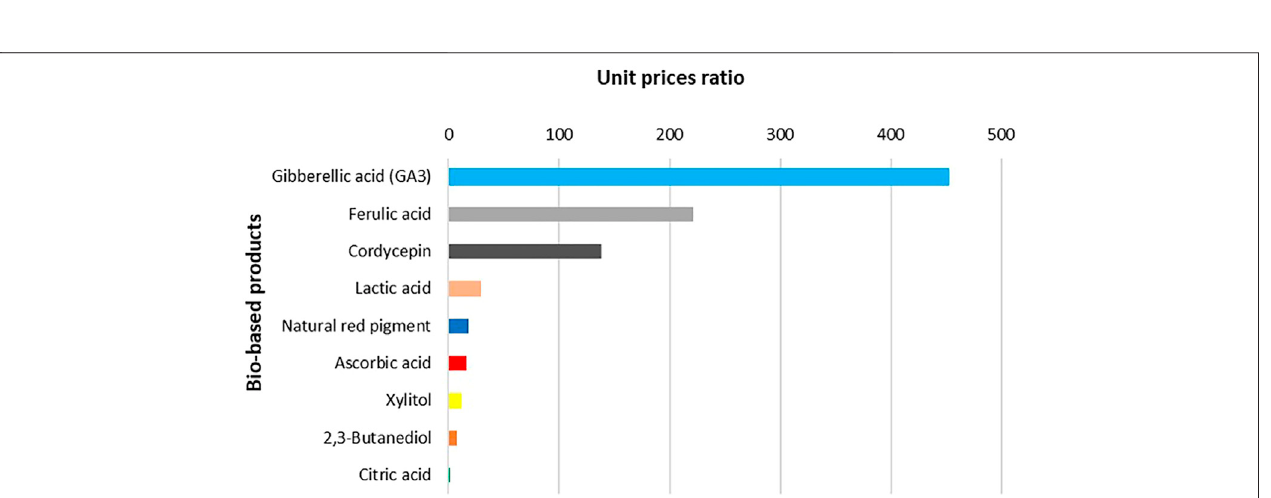
FIGURE 3 | Relative ratios of unit prices per selected value-added products from BSG.